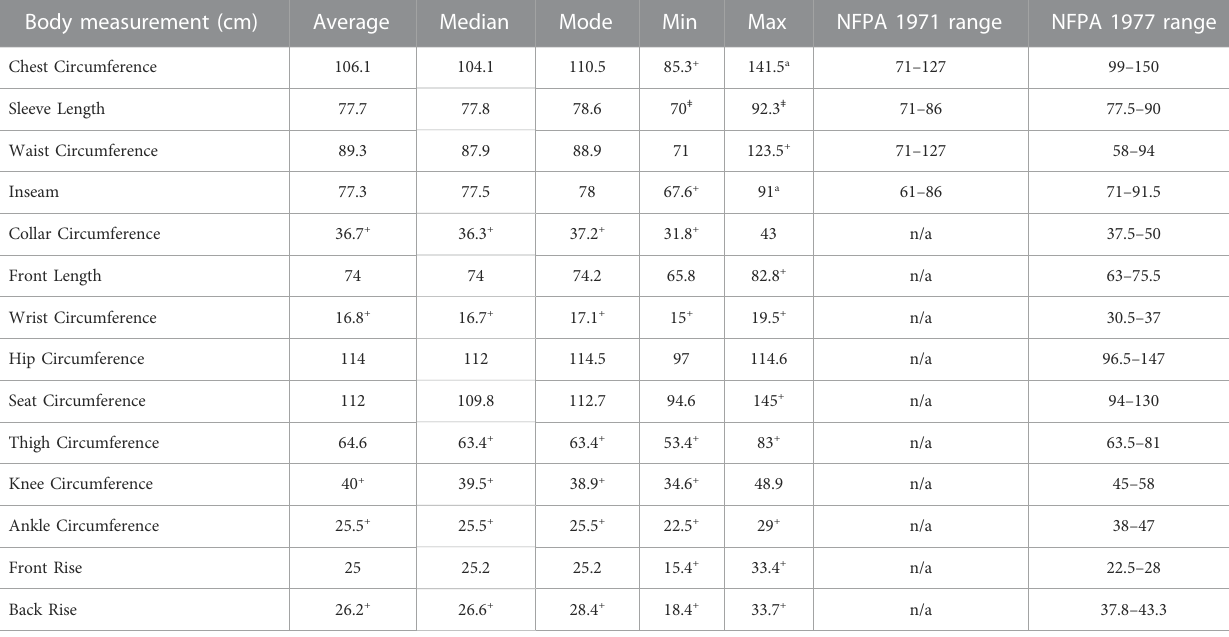
TABLE 3 Descriptive statistical analysis compared to NFPA standards/. Body measurement